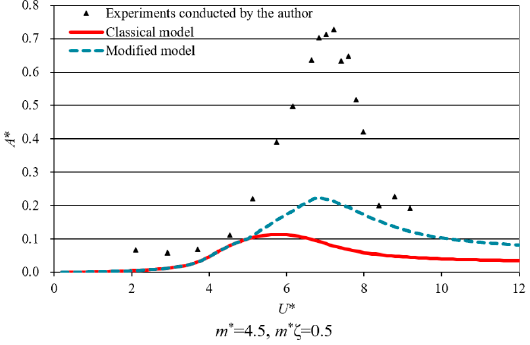
Figure 10. Responses of the maximum amplitude versus reduced velocity ( m * = 4.5, m * ζ = 0.5).